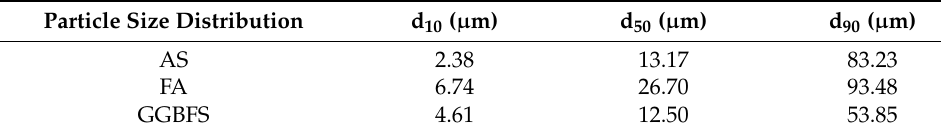
Table 2. The analysis of particle sizes of AS, FA, and GGBFS.